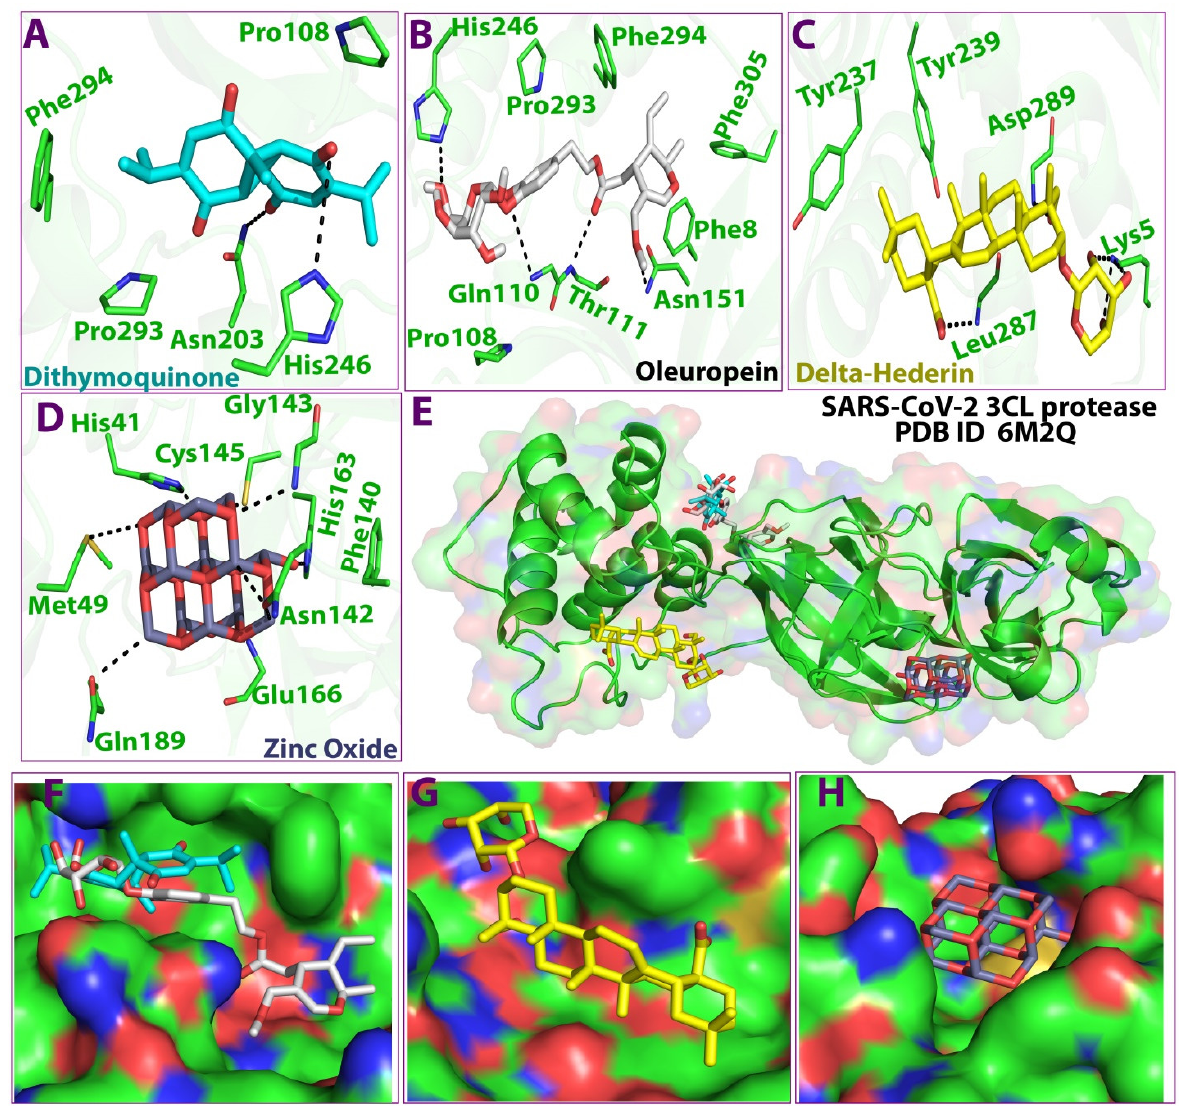
Figure 3. 3D Ligand–receptor interaction map of top scored compounds in the zinc NLC with SARS-CoV-2 (3CLpro). ( A ) dithymoquinone, ( B ) oleuropein, ( C ) delta-hederin ( δ -hederin), ( D ) zinc oxide, ( E ) interaction map showing all four compounds, ( F ) binding cavity of the protein showing dithymoquinone and oleuropein, ( G ) binding cavity of the protein showing delta-hederin, ( H ) binding cavity of the protein showing zinc oxide.